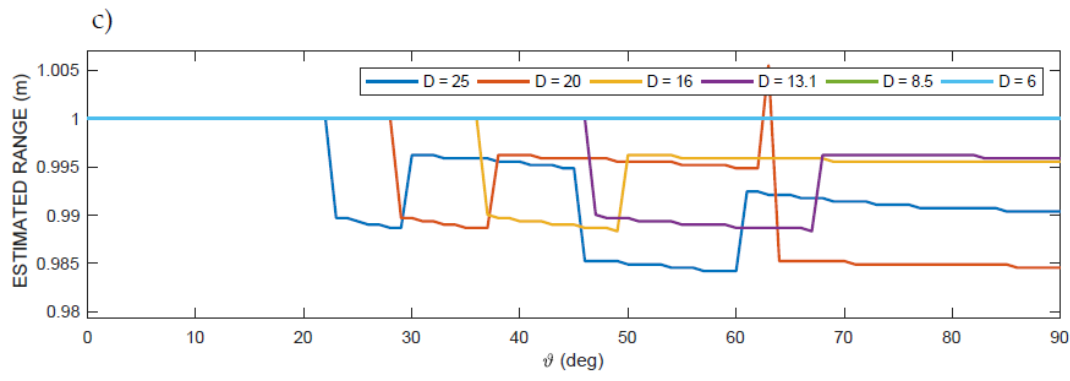
Figure 3. Numerical results at different transducer apertures D = {25, 20, 16, 13.1, 8.5, 6} mm along a semicircular path at distance R = 1 m from the emitting transducer, using a linear chirp with starting frequency f L = 30 kHz and final frequency f H = 50 kHz. A linearized air absorption around 40 kHz (slope 39.3 dB/m·MHz, constant term -0.262 dB/m, i.e., about 0.917 dB/m @ 20 kHz and 1.703 dB/m @